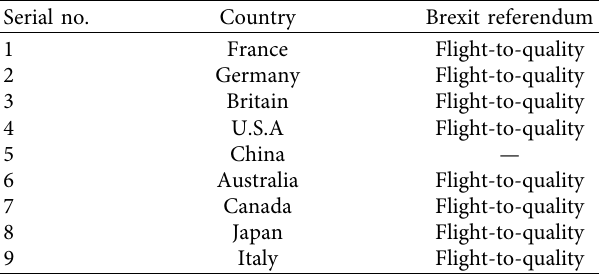
Table 3: Statistical results of cross-market efects. Serial